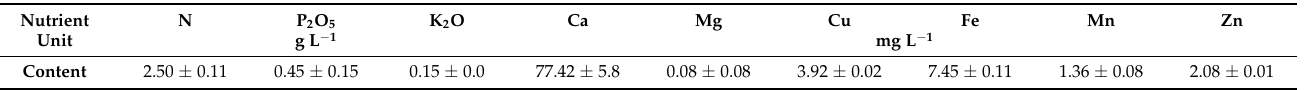
Table 2. Main chemical characteristics of the liquid biofertilizer (digestate of swine wastewater) tested in the